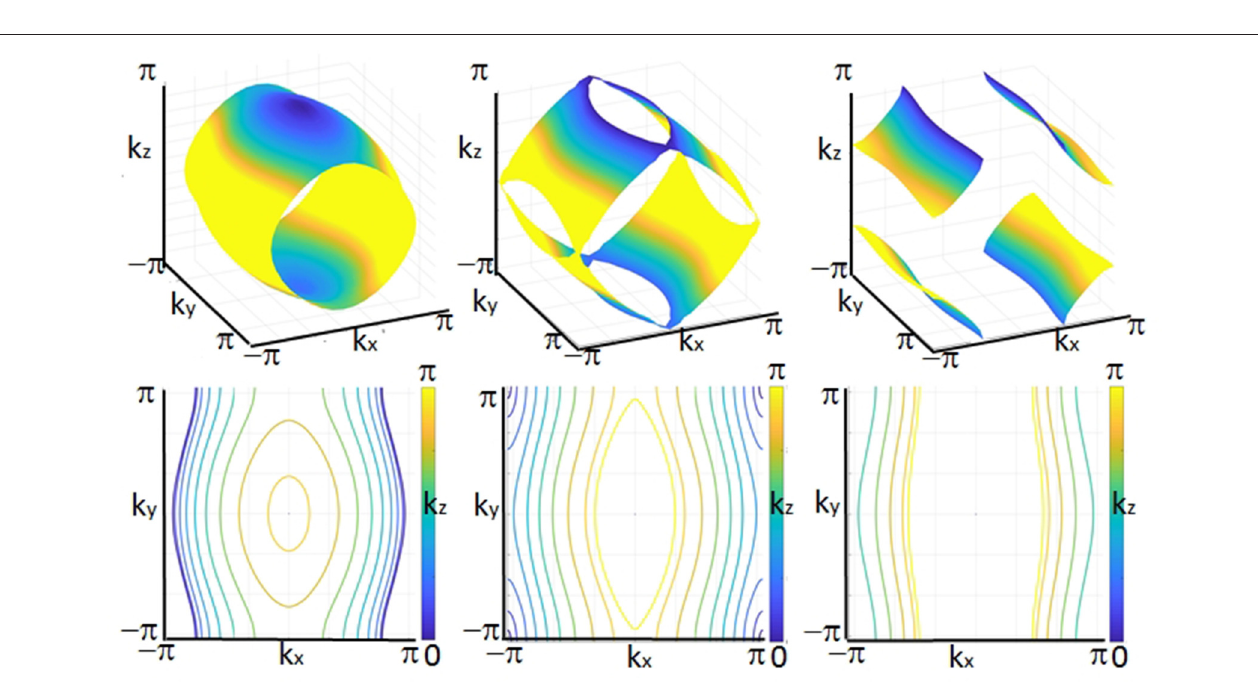
FIGURE 12 | Eigenfunctions for embedded resonators corresponding to the eigenfrequency ω ∗ 1 eigenfrequency ω ∗ 2 118.975 rad.s − 1 (right panel). In left panel both canals vibrates, while in right panel only the inner canal does. The second eigenfrequency = ω ∗ 2 118.975 rad.s − 1 is reasonably well approximated by the first eigenfrequency of the spring mass model which gives and ω 1 = ω 2 208.4109 rad.s − 1 . =